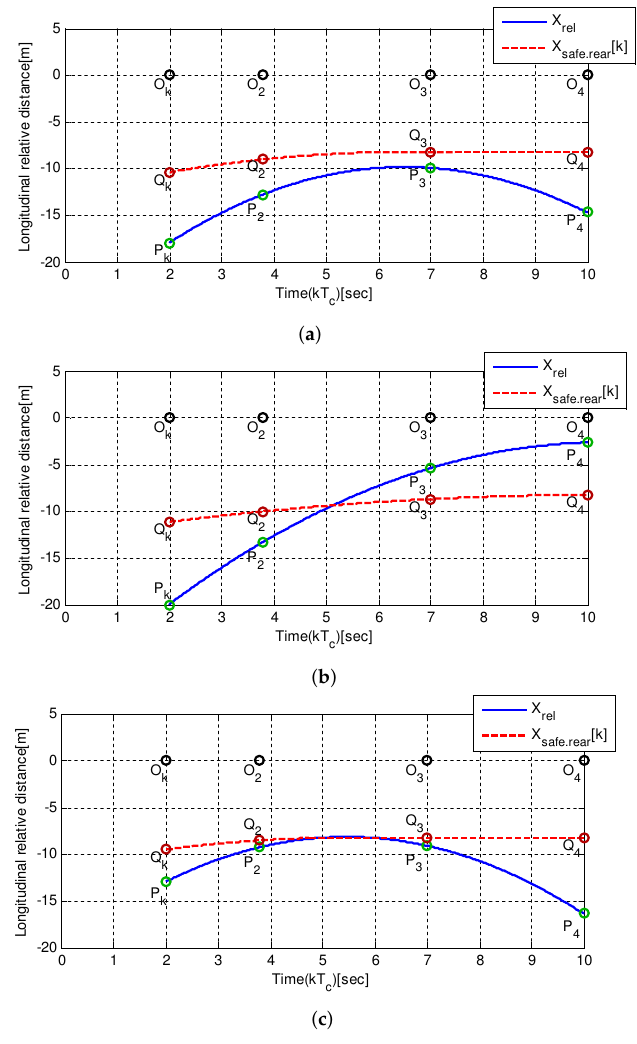
Figure 3. Case study for the relative distance and safety margin. ( a ) Case 1: The collision risk is safe. ( b ) Case 2: The collision risk is danger. ( c ) Case 3: Need to check the local maximum